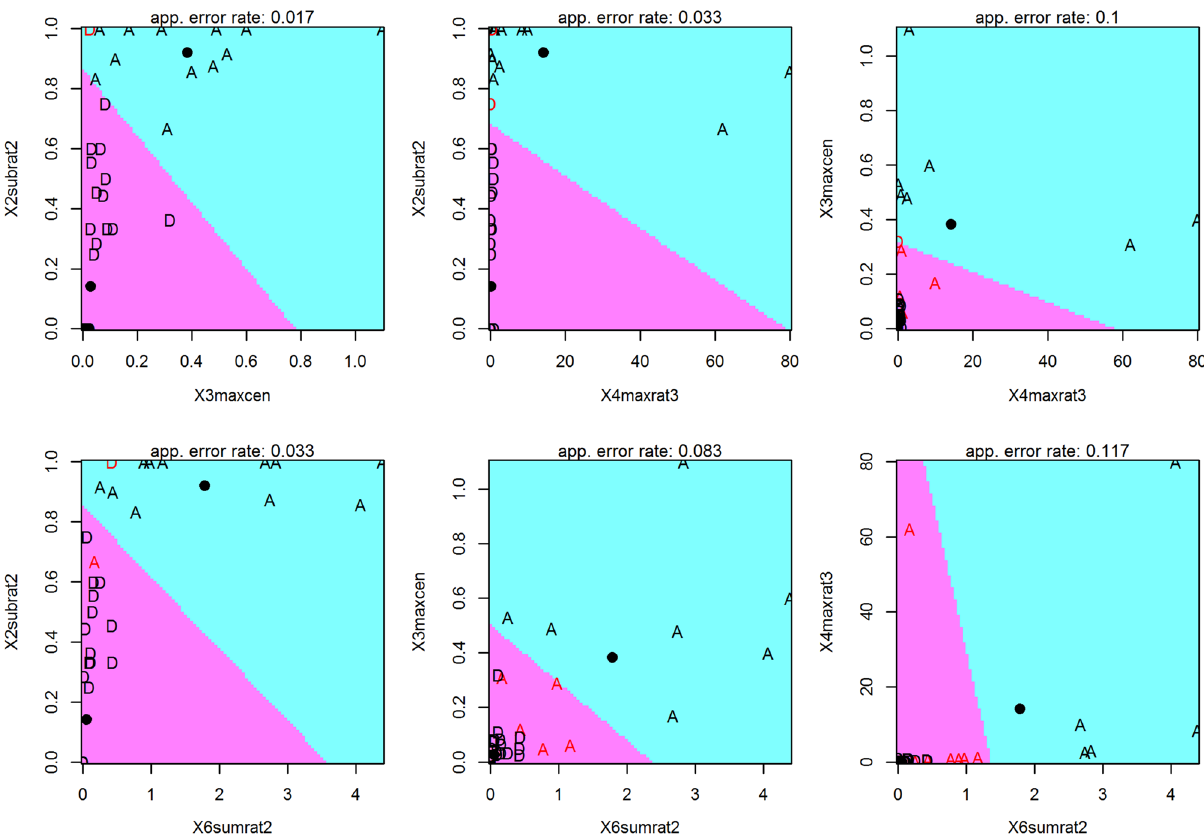
Figure 7. Linear discriminant function for the four selected variables. The D represents the true “drift” cases while A represents the true “application” cases. The two colours represent the decision rule: cases falling into the magenta region are classified as “drift”, cases falling into the turquoise region are classified as “application” cases. Misclassified farms are plotted in red, correctly classified ones in black. The black dots represent the group